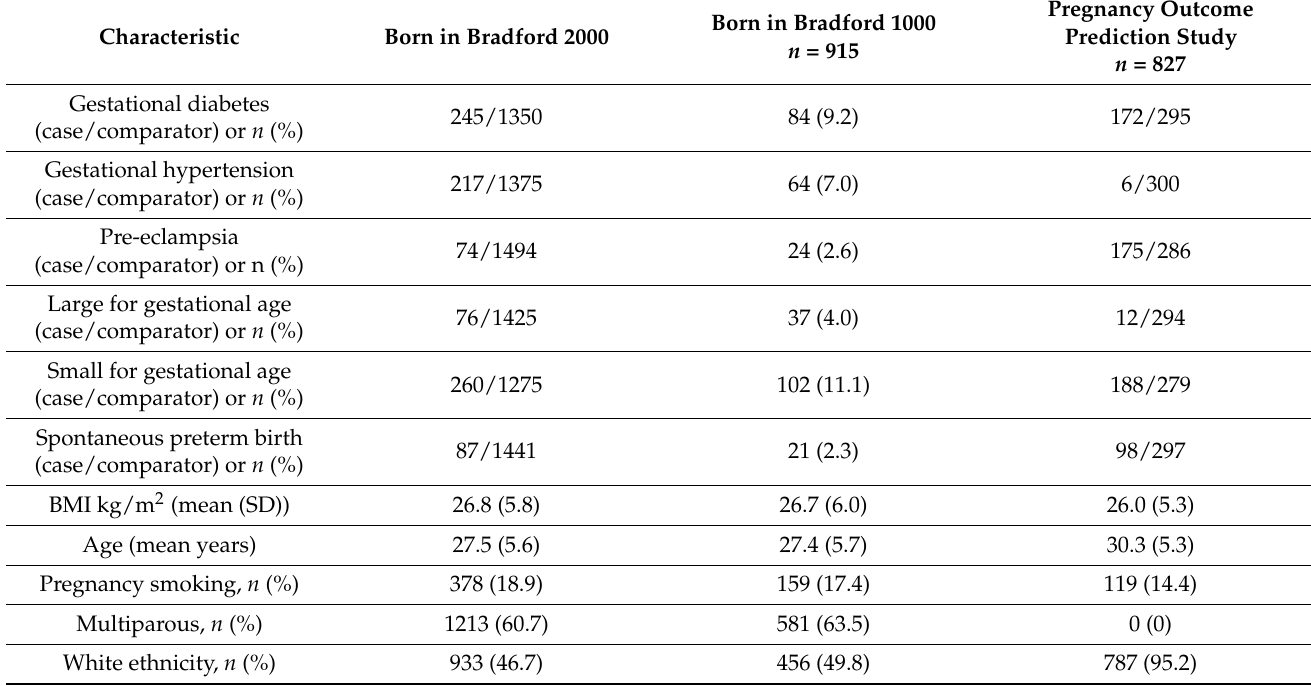
Table 1. Participant characteristics from the three participating cohorts: Born in Bradford 2000, Born in Bradford 1000 and the Pregnancy Outcome Prediction